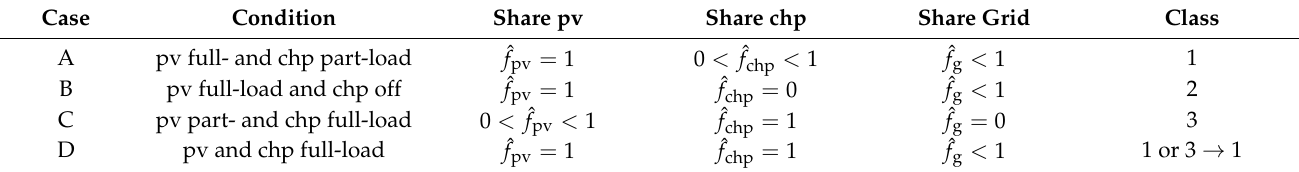
Table 3. Example: assignment of classes with conditions of capacity share